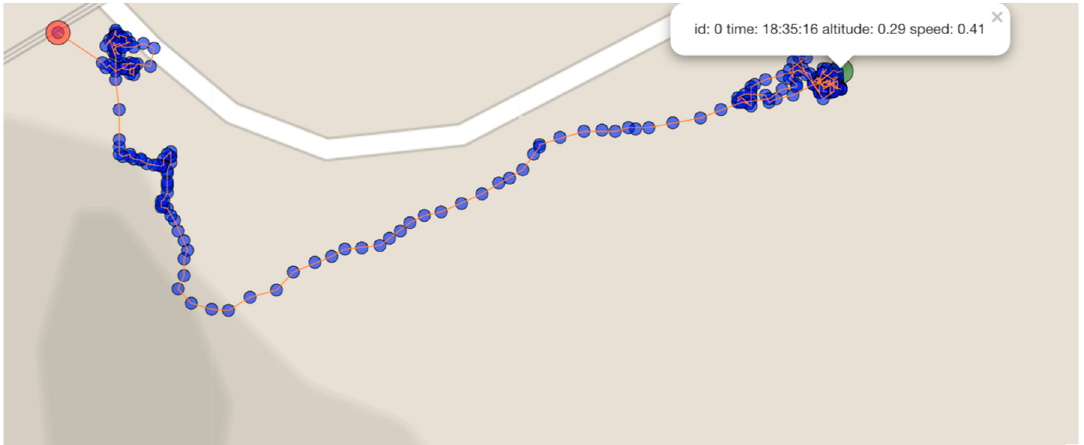
Figure 21. Mobile node GPS sample retrieval.